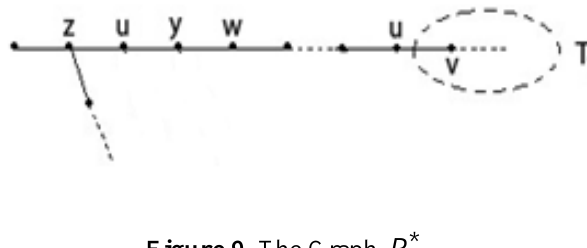
Figure 9 . The Graph